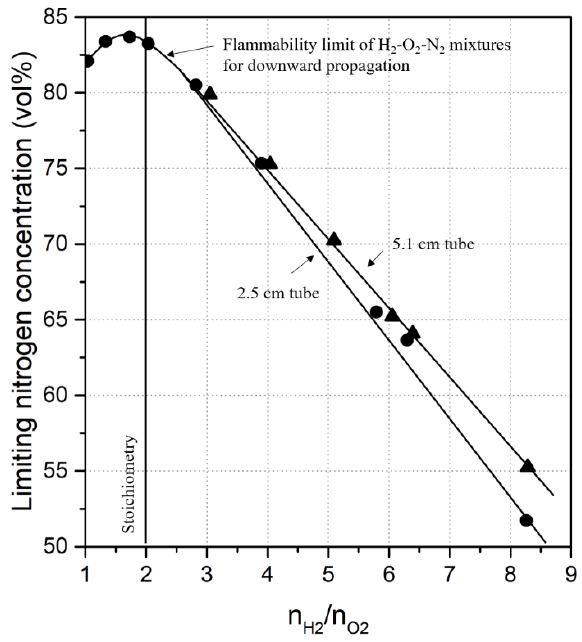
Figure 18. Limiting mole percent of nitrogen as a function of the hydrogen-oxygen ratio for downward propagation. Reproduced from Ref. [64], The Combustion Institute: 1978.